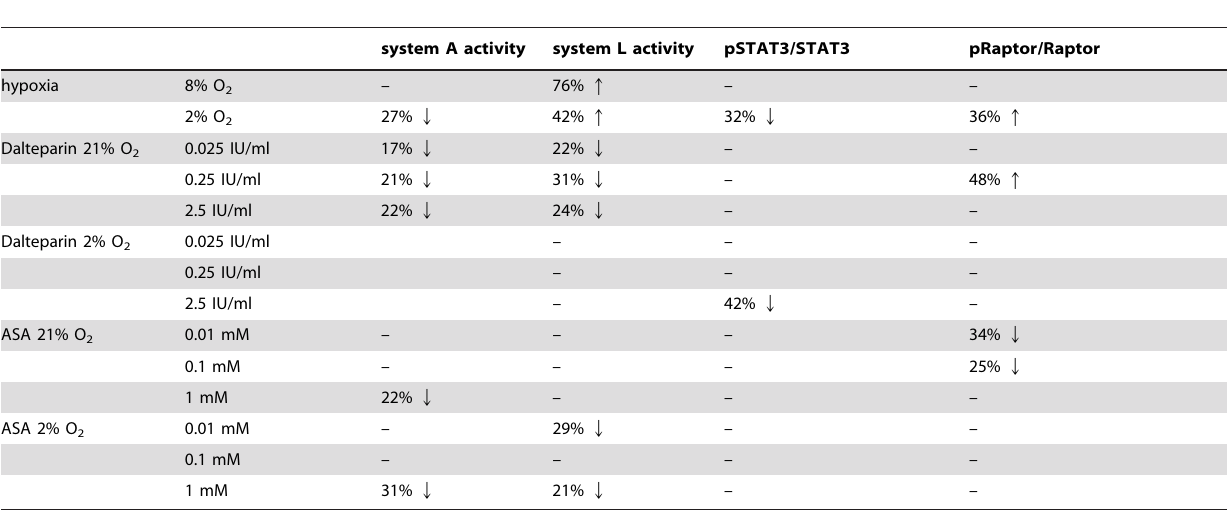
Table 1. The table summarizes the different effects of dalteparin, ASA and hypoxia on system A and L amino acid transport, pSTAT3/STAT3 and pRaptor/Raptor ratio.